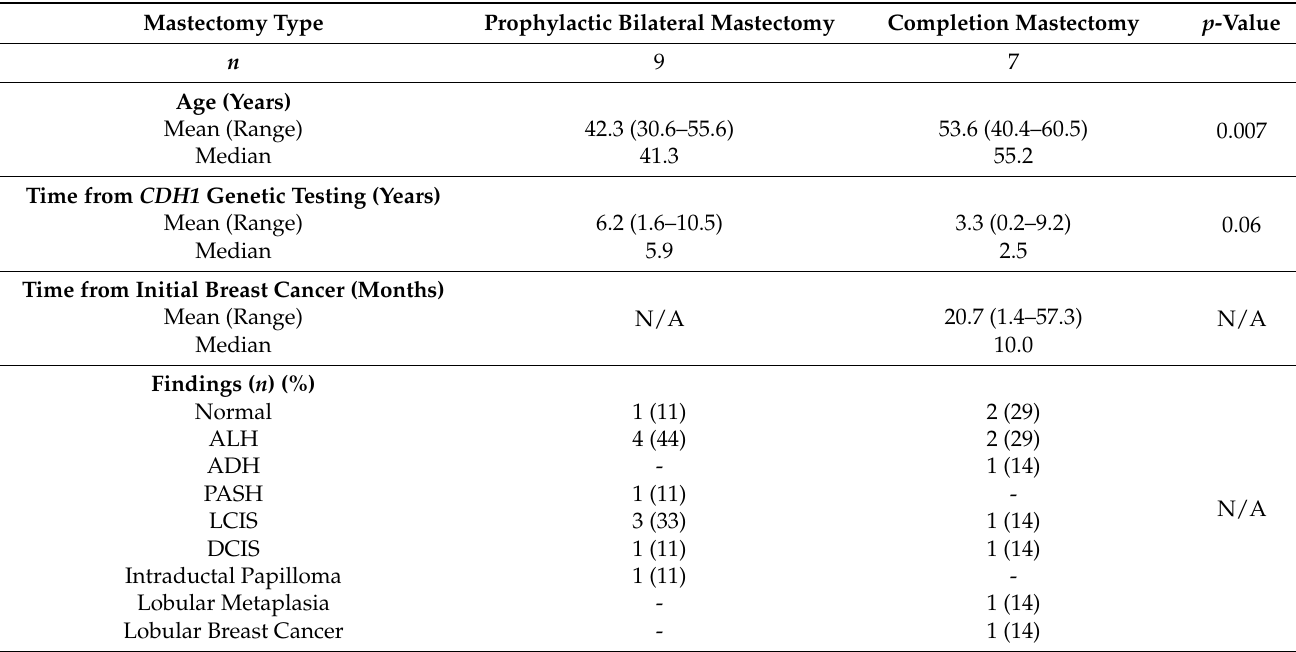
Table 2. Overview of female CDH1 mutation patients undergoing prophylactic mastectomy (16 out of 17 patients) in Newfoundland and